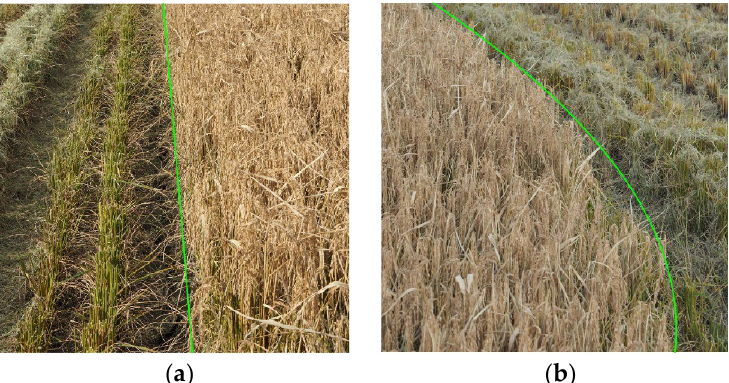
Figure 12. Dividing point fitting effect: ( a ) Straight cut-edge; ( b ) Curved cut-edge.